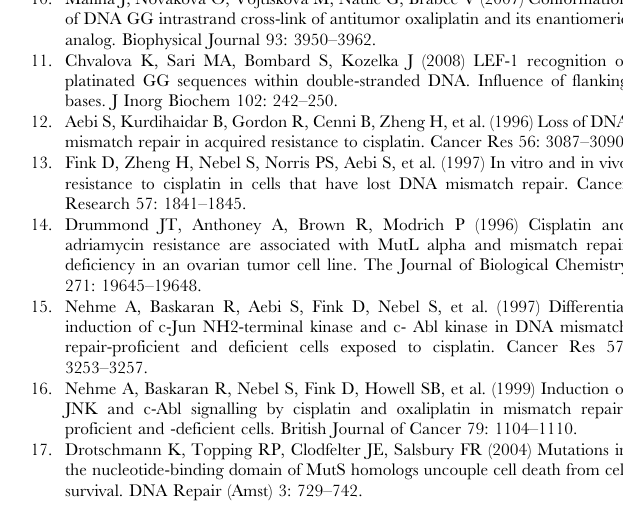
propellor twist ( D ), 5–20 buckle ( E ), 5–6 roll ( F ). The value of the each corresponding helical parameter in the crystal structure of HMGB1a-CP-DNA is indicated with a dashed vertical line. (TIF) Figure S5 Conformational differences between differ- ent hydrogen bonded species in CP- and OX-DNA in the TGGT sequence context. The conformational differences in the central four base pairs between structures forming G7-O6 hydrogen bond and structures forming no hydrogen bond to the drug; between structures forming T8-O4 hydrogen bond and structures forming no hydrogen bond to the drug and between structures forming the T8-O4 hydrogen bond and structures forming the G7-O6 hydrogen bond are plotted for CP-DNA ( A ) and OX-DNA ( B ) in the TGGT sequence context. The differences are represented as the KS ratio (described in Methods) displayed on a heat map. The heat map is color-coded and the KS ratio decreases in the order of Black to White according to the scale shown at the bottom of the heat map. (TIF) Text S1 Supplemental NMR Experimental Procedures. Table S1 1H NMR shifts (ppm) of the OX-DNA in the TGGT sequence context recorded in D2O buffer and at Table S2 1 H NMR shifts (ppm) of non platinated DNA in the TGGT sequence context recorded in D 2 O buffer at Table S3 Helical parameters of the NMR